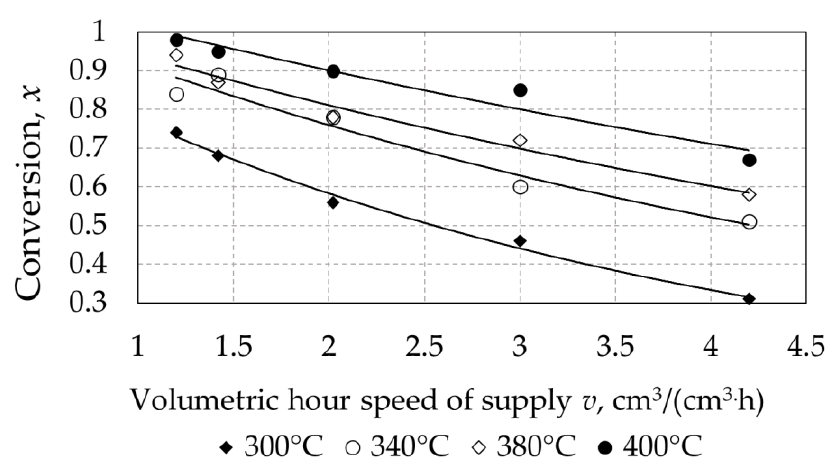
Figure 1. Dependence of the conversion of sulfur compounds on the volumetric speed of supply of diesel fraction to the reactor at different temperatures in the reactor, °C.